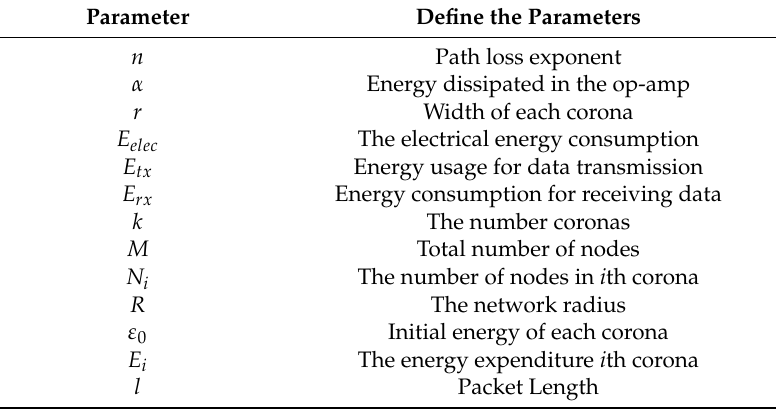
Table 1. Parameters